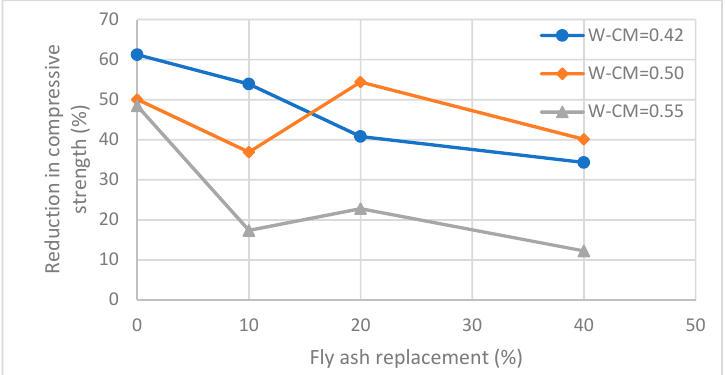
Figure 7. Relationships between compressive strength loss and proportion of fly ash replacement.